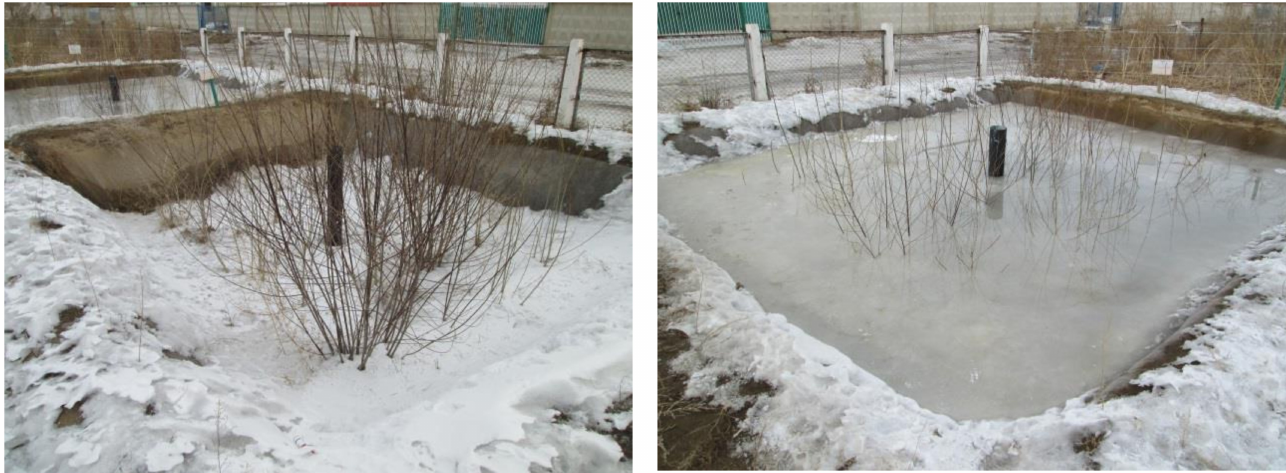
Figure 4. The pilot treatment beds. Bed A operated with external winter storage and summer irrigation (left) and bed B operated with internal winter storage, where the wastewater is stored on top of the treatment area during